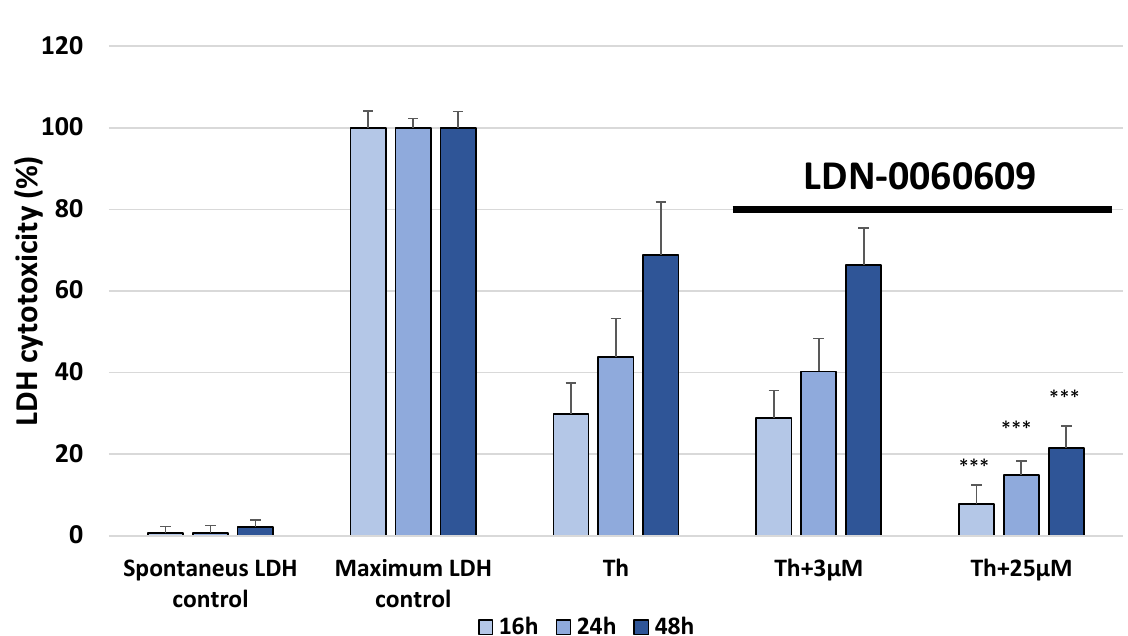
Figure 4. Analysis of cytotoxicity of the PERK inhibitor LDN-0060609 only ( A ) and after treatment of HTM cells with the Th and PERK inhibitor LDN-0060609 ( B ) by the lactate dehydrogenase (LDH) assay. Each of the statistical analyses in the individual experiments was based on the results of three independent tests. Data are expressed as mean ± SE ( n = 3). On the graphs, the differences were statistically significant as follows: *** p < 0.001 versus the spontaneous LDH control ( A ) and Th ( B ). DMSO—dimethyl sulfoxide;